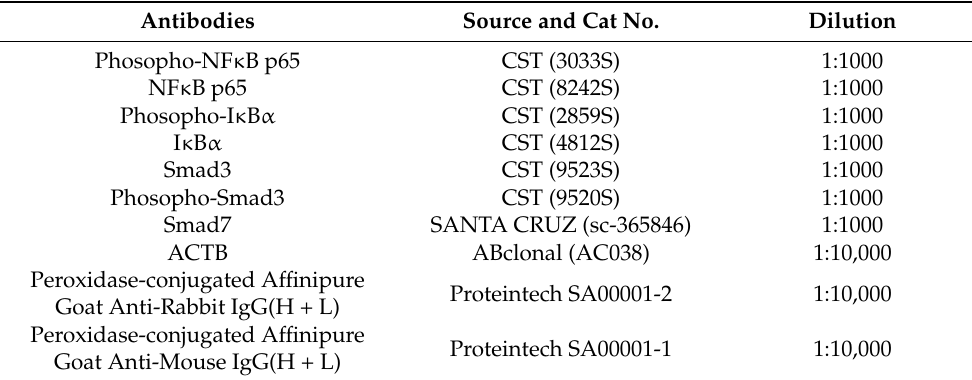
Table 4. Antibody information for Western